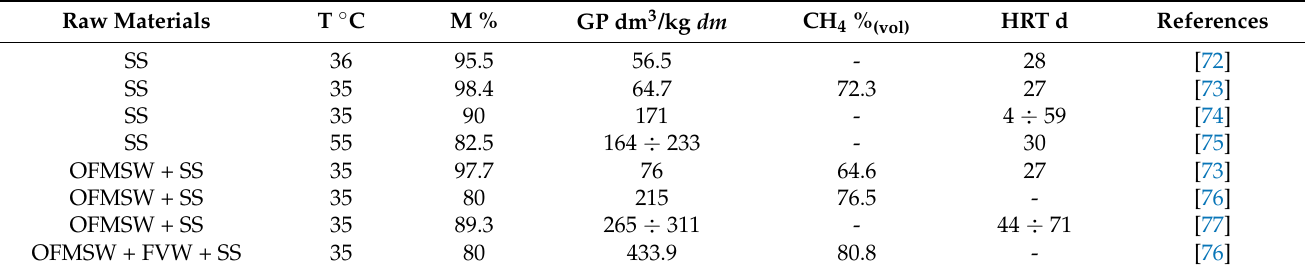
Table 5. The indicators used to determine WFI and DRI yield of gas